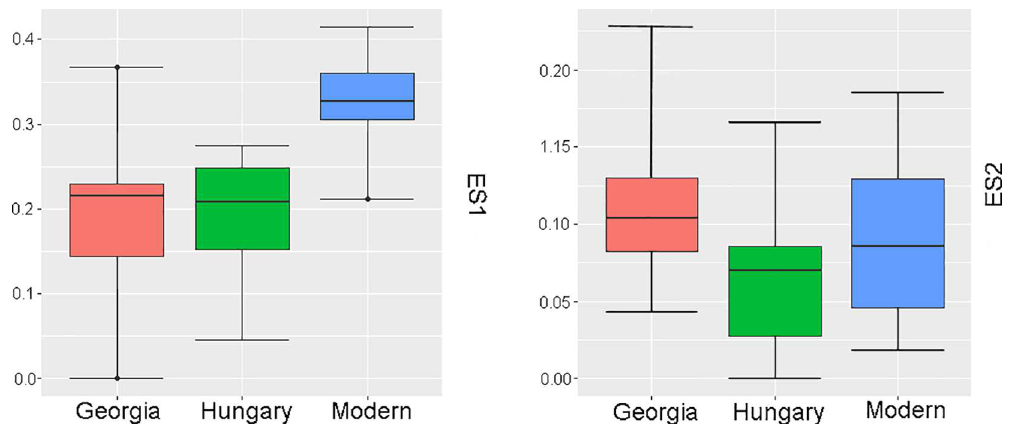
Fig 9. Box-and-whisker plots showing eigenshape scores for the Georgian, Hungarian and modern crania on ES1 and ES2.